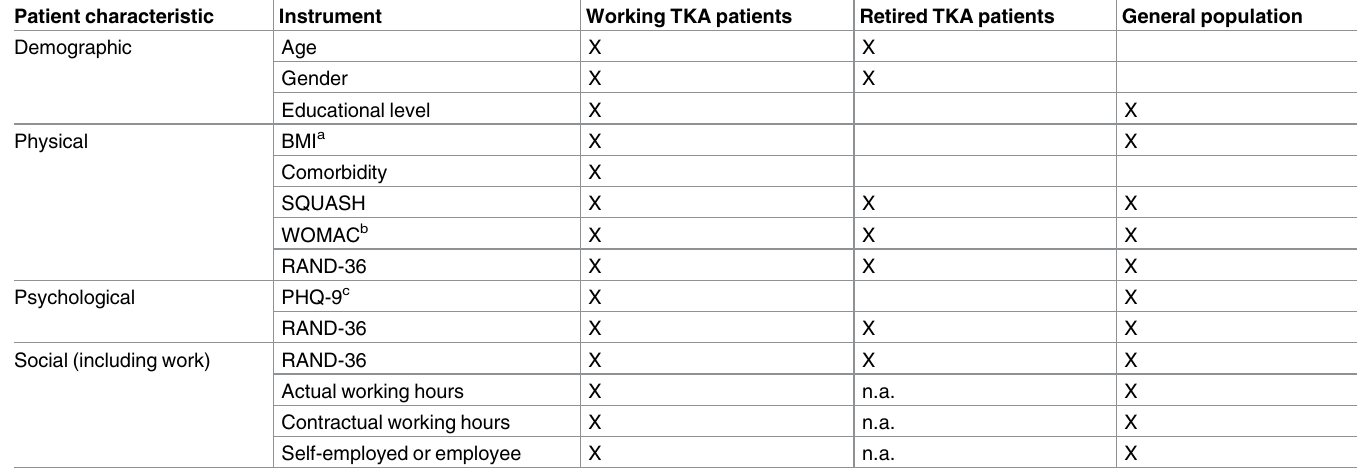
Table 1. Overview of the available data of different questionnaires of working TKA patients, retired TKA patients and the general population. Patient